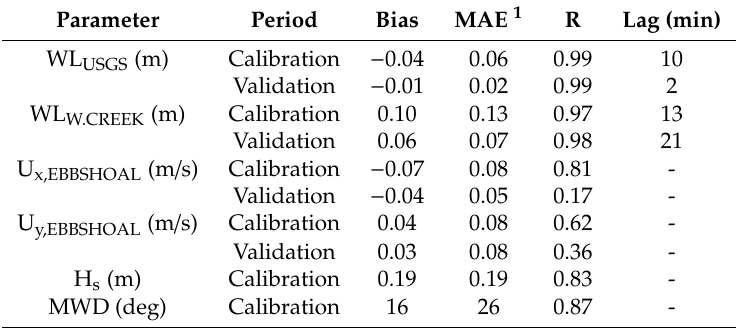
Table 4. Goodness-of-fit statistics of current velocities for model calibration and validation periods. Parameter